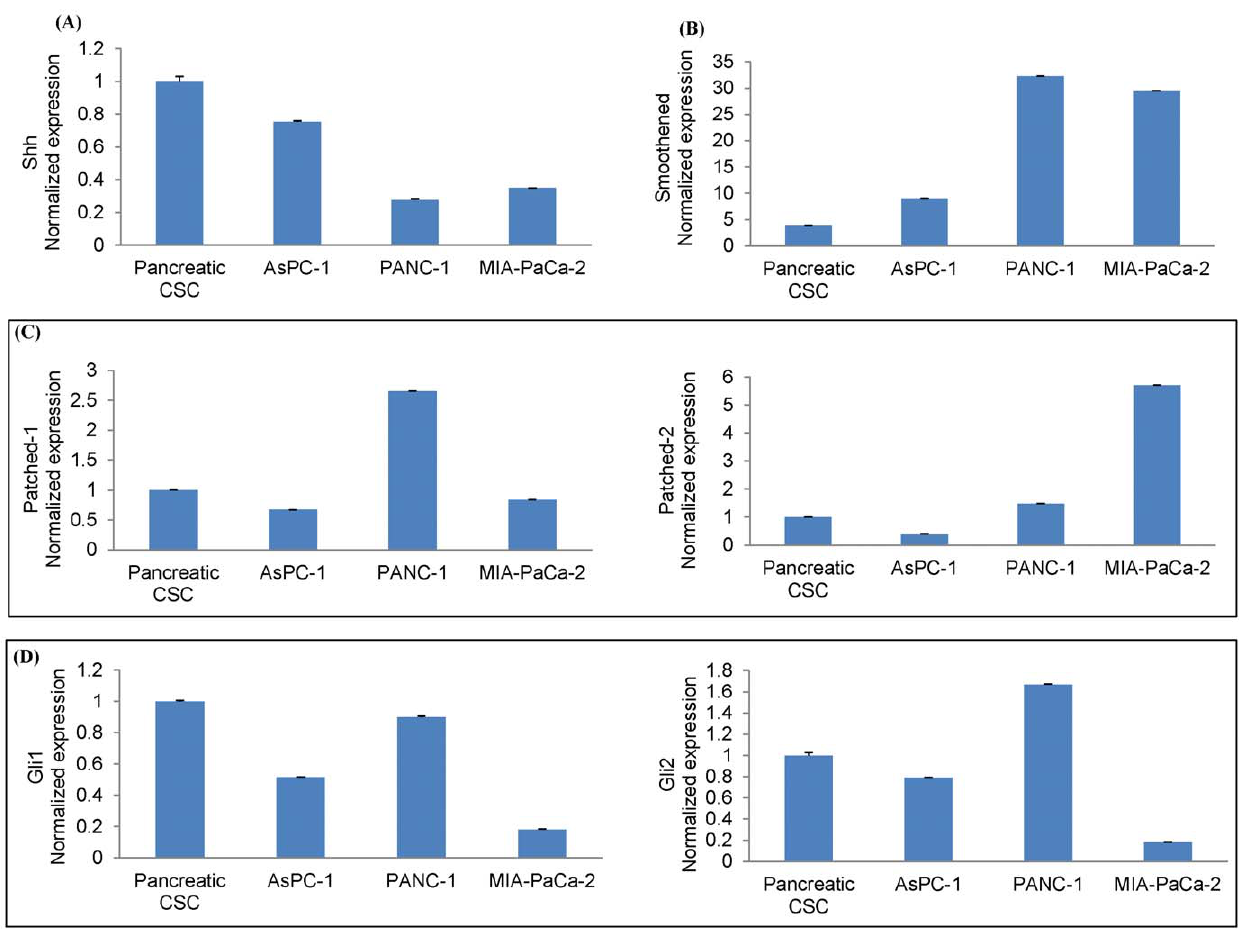
Figure 1. Expressing components of Sonic Hedgehog (SHH) signaling pathway in human pancreatic cancer cell lines and pancreatic cancer stem cells (CSCs). Pancreatic cancer cells (AsPC-1, PANC-1 and MIA PaCa-2) and pancreatic CSCs were grown for 48 h. Total RNA was isolated and expression of Shh, Patched-1, Patched-2, Smoothened, Gli-1 and Gli-2 was measured by qRT-PCR. HK-GAPD was used as endogenous normalization control. All assays were performed in triplicate and were calculated on the basis of DD C t method. The n-fold change in mRNAs expression was determined according to the method of 2 - DD CT with GAPDH employed as the endogenous control.